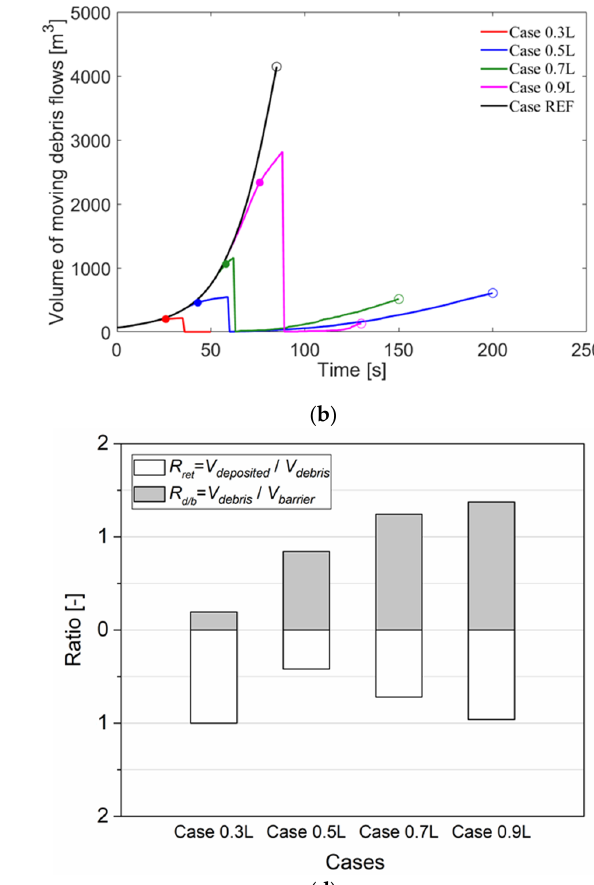
Figure 3. Snapshots at the end points of the debris flow simulations: ( a ) before the event; ( b ) Case REF; ( c ) Case 0.3 L; ( d )